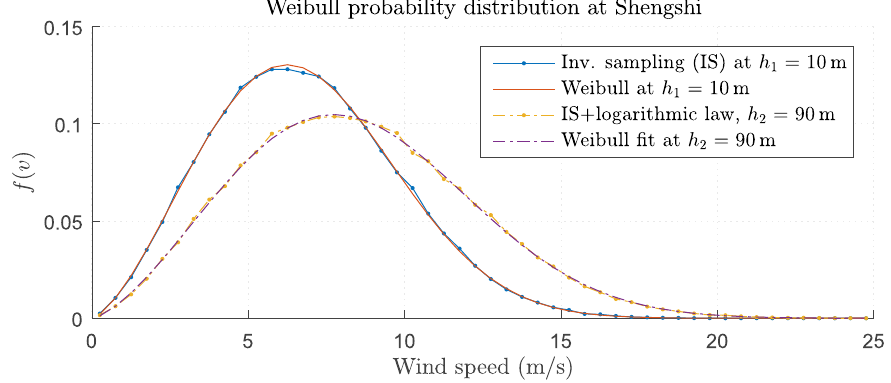
Figure 1. Measured and estimated Weibull probability distributions at Shengshi at heights of 10 m and 90 m, respectively.